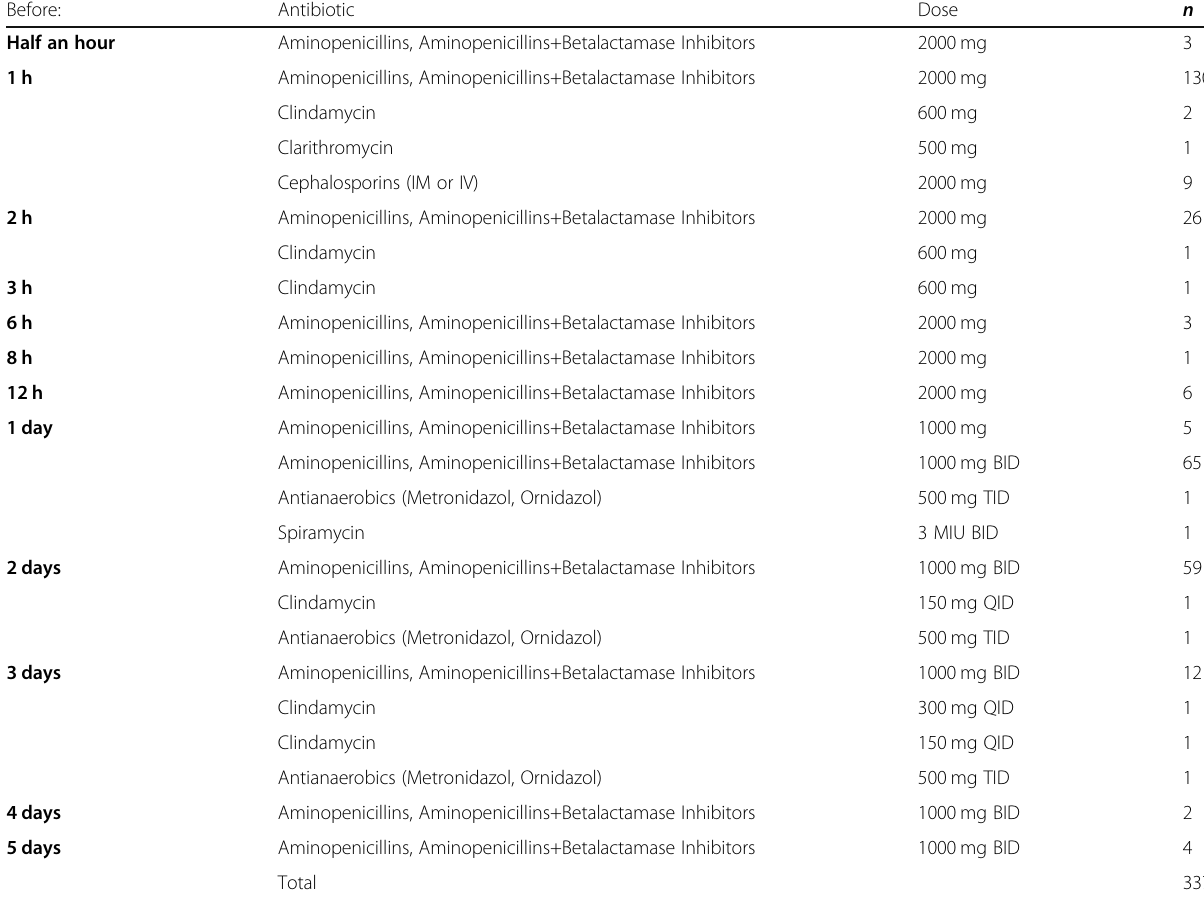
Table 8 Preoperative antibiotics preferred by the clinicians with regimen and dosage